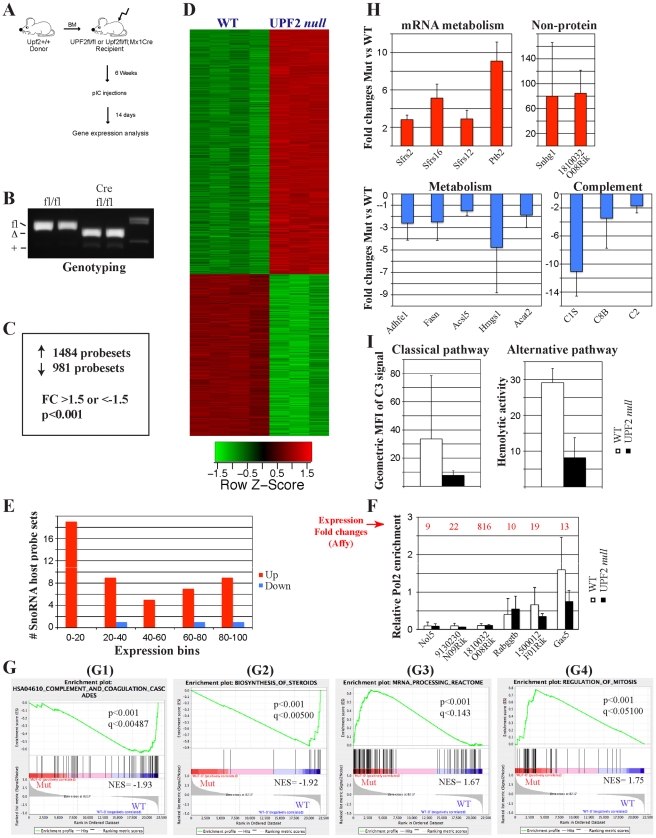
Gene expression analysis of UPF2-deficient adult livers.(A) Experimental strategy for the induction of UPF2 loss in the adult liver of BM transplanted control (Upf2fl/fl) and Upf2fl/fl; Mx1Cre mice. (B) Genotyping of control and UPF2 null mice 2 weeks after the first pIC injection demonstrates efficient deletion in liver. (C) Summaries of deregulated probesets in control and UPF2 null adult livers. (D) Cluster analysis of normalized affymetrix expression data from control and UPF2 null adult livers. (E) Distribution of snoRNA host genes (defined as genes having intron-encoded snoRNAs) among up and down-regulated genes. 0–20, 20–40 etc. indicates percentiles within up and down-regulated probesets. Thus, 0–20 indicates the top 20% of up and down-regulated genes. (F) ChIP analysis of RNA Pol2 occupancy of selected snoRNA host genes. Enrichment values are given relative to Actb (normalized to a gene dessert). Expression fold changes (all up in UPF2 null livers) derived from affymetrix gene expression profiling are shown in red above each gene. Immunoprecipitates were performed on two mice of each genotype and assayed by qPCR in triplicates (mean +/− standard deviation). (G) Selected enriched gene sets from GSEA analysis. G1: HSA04610_Complement_And_Coagulation_Cascades, G2: Biosynthesis_of_steroids, G3: mRNA_Processing_Reactome, G4: Regulation_of_mitosis. Normalized enrichment scores, p-value and q-values (FDR) are indicated for each gene set. Negative and positive NES values indicate enrichment in control and UPF2 null adult livers, respectively. Y-axes indicate Enrichment scores (top) and Ranked list metric (bottom). Green lines indicate enrichment profile, black bars are hits (i.e. genes) and grey profiles are ranked metric score. Red and blue indicate positive and negative correlations, respectively, with the indicated gene sets. (H) qRT-PCR validation of deregulated genes belonging to different functional classes in adult UPF2 null livers. “Non-protein” indicates SnoRNA host genes. Red and blue colors indicate up-regulated and down-regulated genes, respectively, in UPF2 null adult livers. cDNA was synthesized from 3 mice of each genotype and assayed by qPCR in triplicates (mean +/− standard deviation). (I) Functional assessment of the classical and alternative complement pathways in control and UPF2 null adult sera. The data represent the average of 3 experiments each involving 5–7 mice of each genotype (mean +/− standard deviation).